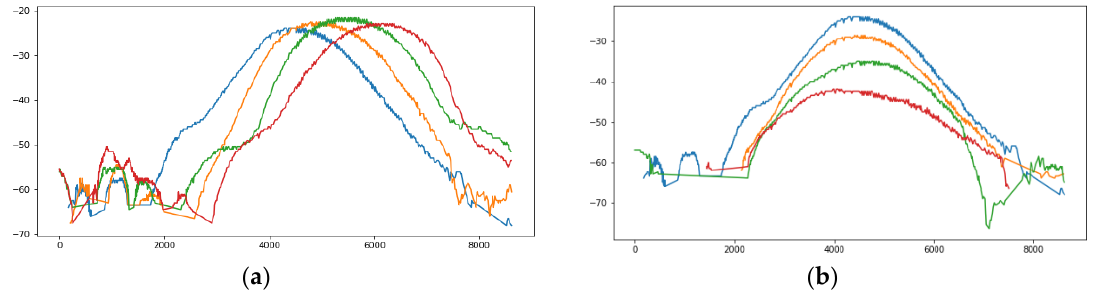
Figure 8. RSSI data changes. ( a ) In one row; and, ( b ) in one column.